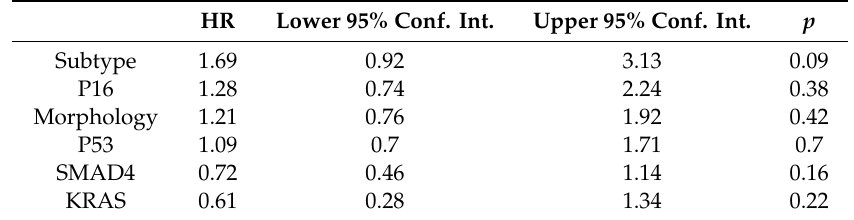
Table 3. Results of the Cox proportional hazards modelling for parameter group 2 (histo-morphologic and genetic parameters). HR Lower 95% Conf. Int. Upper 95% Conf. Int.